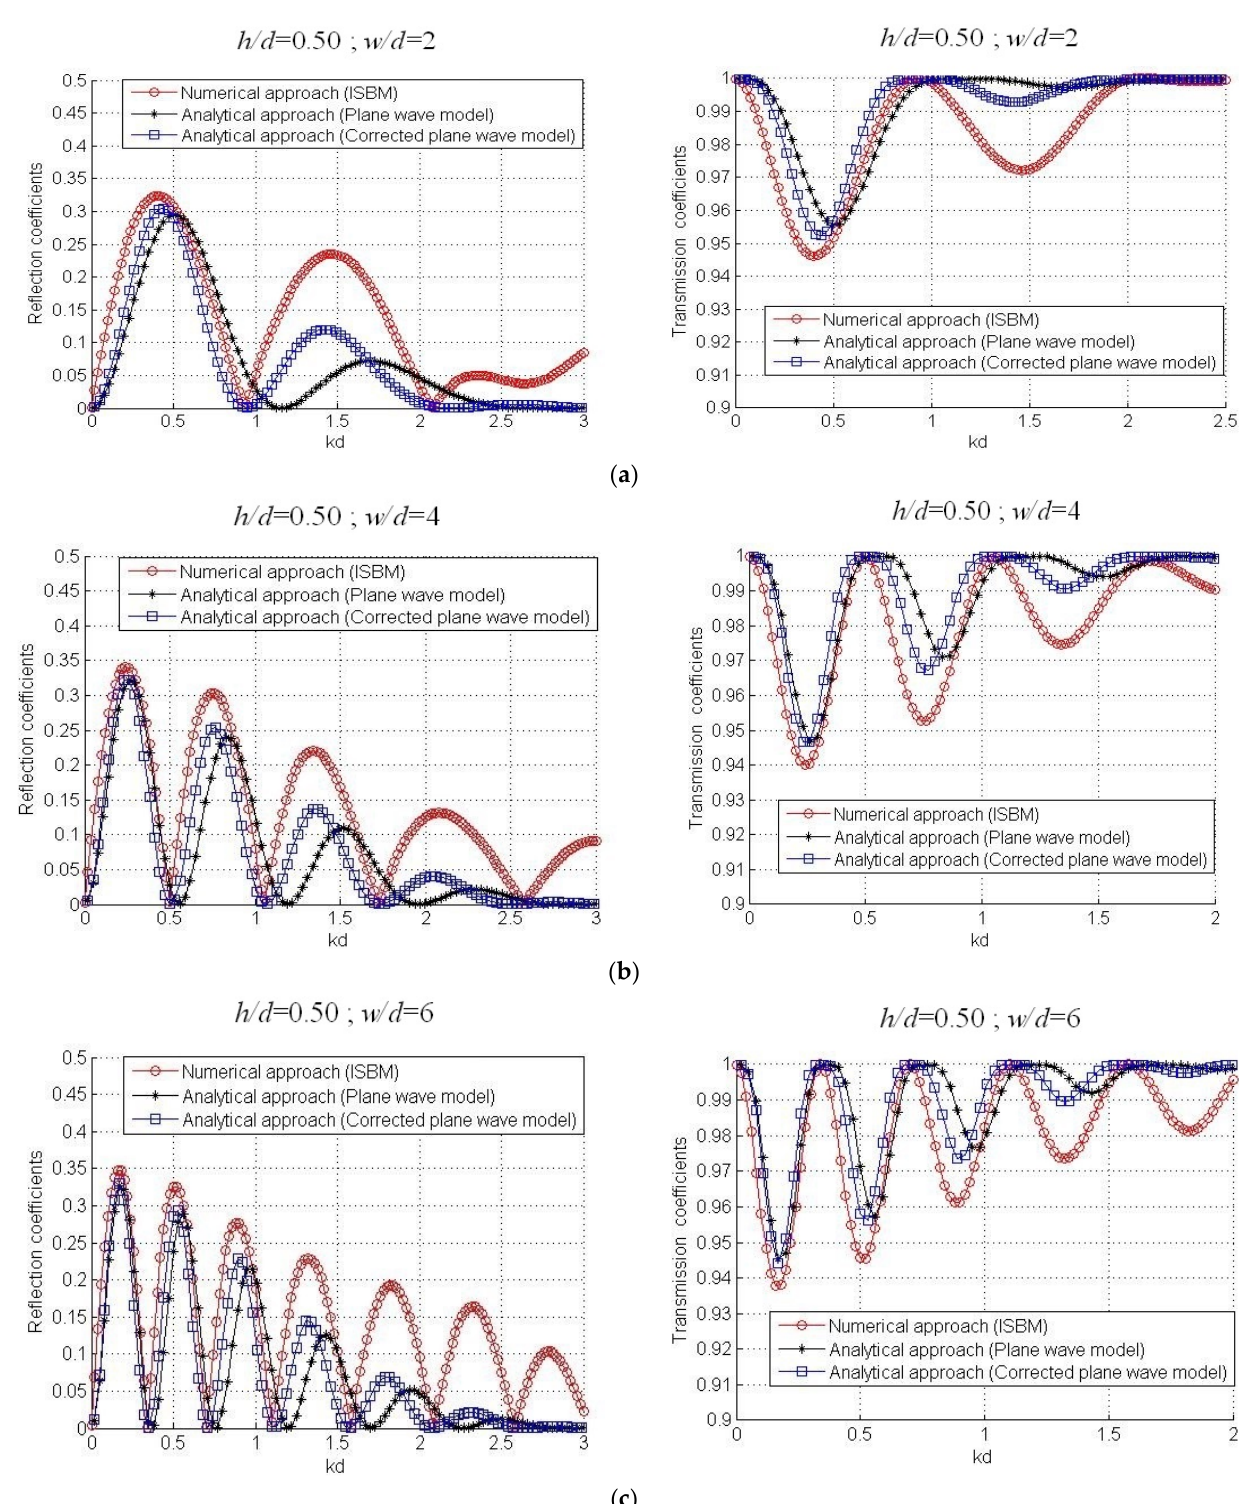
Figure 8. Variations of reflection and transmission coefficients by fixing the immersion ratio at h/d = 0.50 and varying the relative length: ( a ) w/d = 2, ( b ) w/d = 4, and ( c ) w/d = 6.